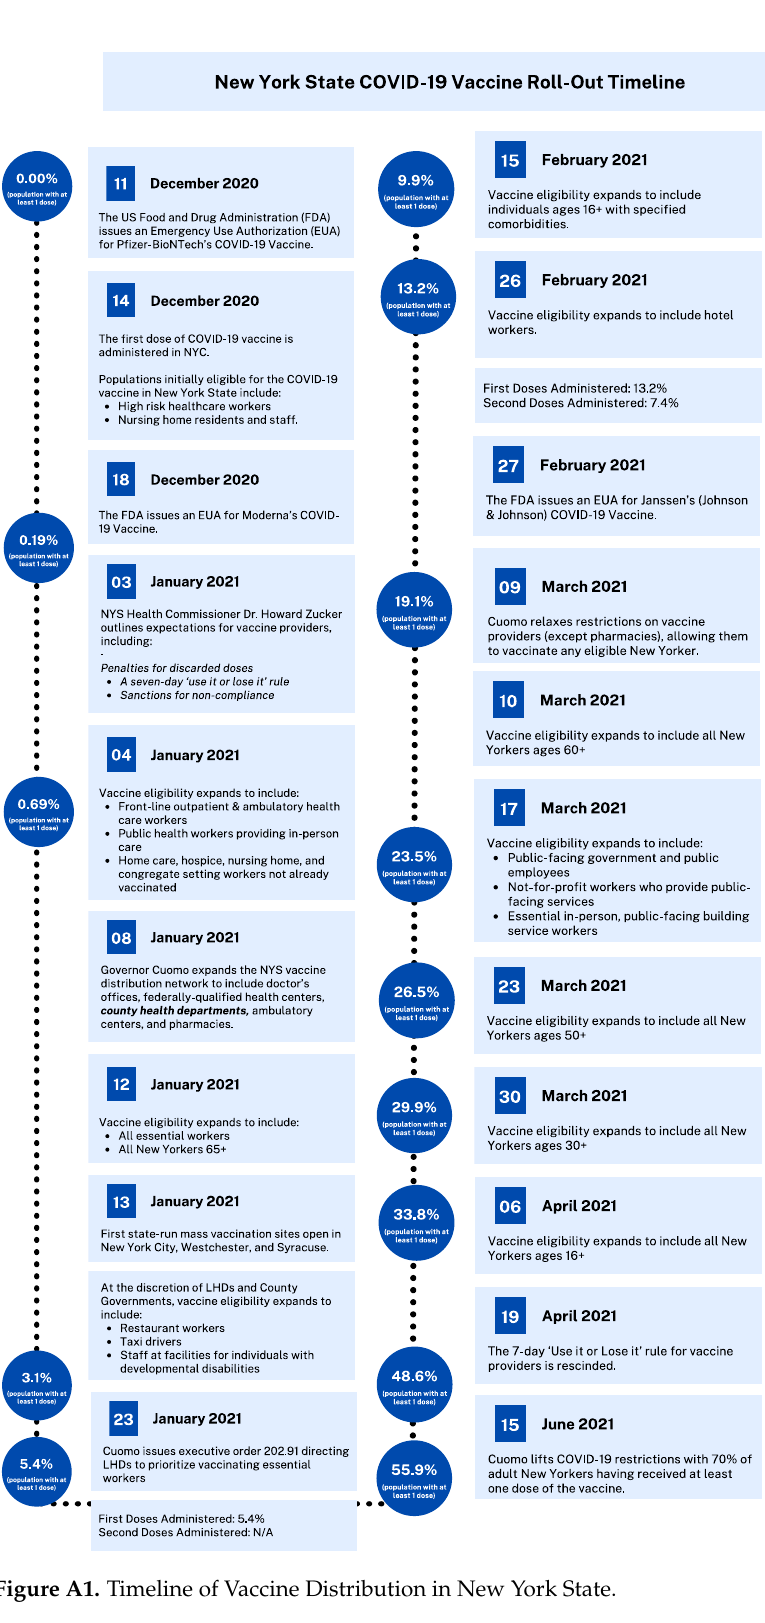
Figure A1. Timeline of Vaccine Distribution in New York State.